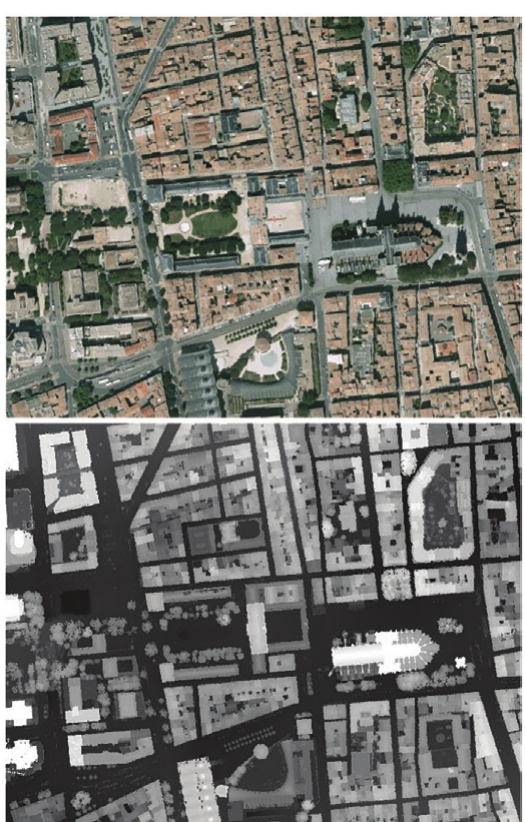
Fig. 8. Ortophotomap of the centre of Bordeaux and the corresponding Digital Surface Model (the brighter the